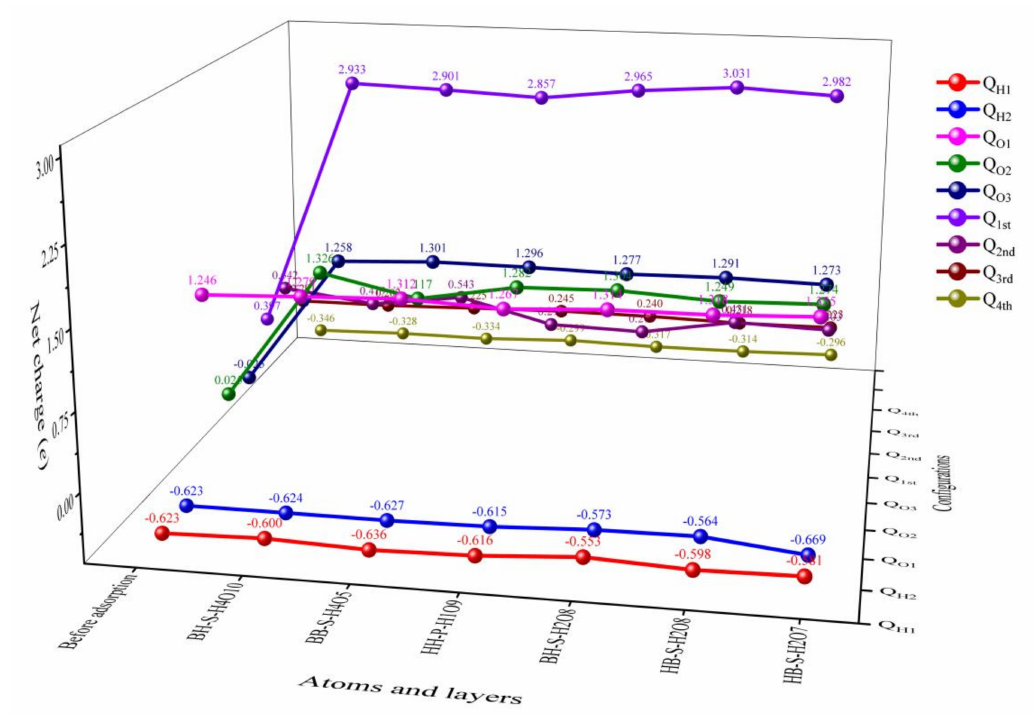
Figure 6. The trend figure of net charge distribution of co-adsorption stable configuration obtained when H 2 O is preferen- tially